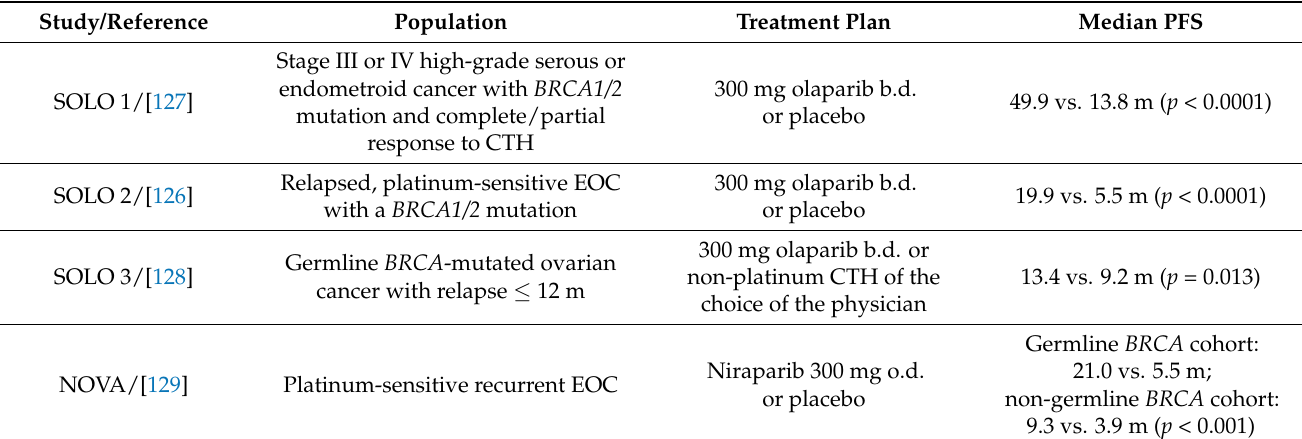
Table 2. Studies of PARP inhibitors in recurrent